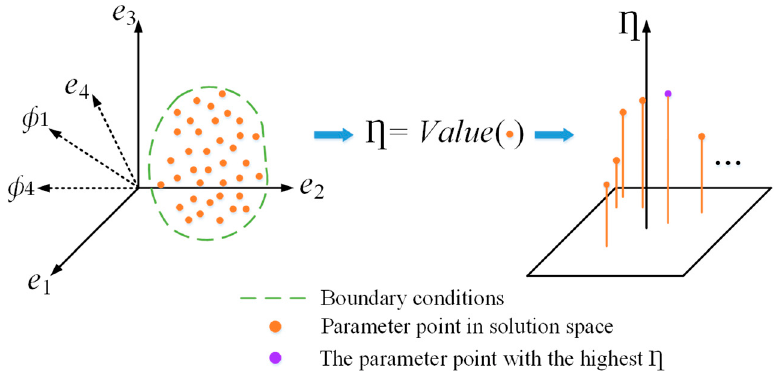
Figure 3. Initial structure solving process of the zoom system.